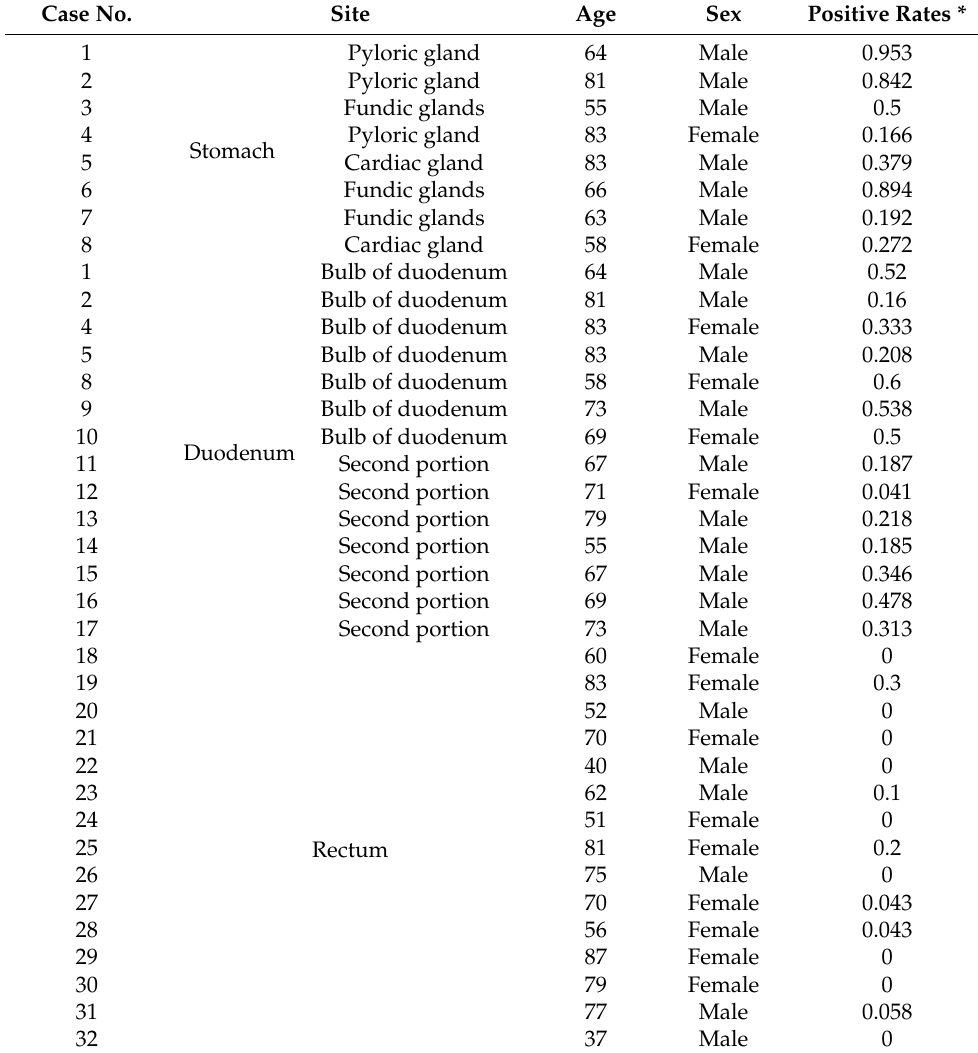
Table 4. Summary of the clinicopathological characteristics of Group